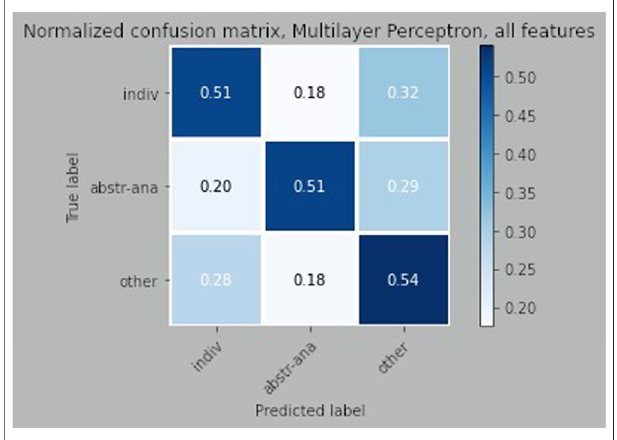
FIGURE 2 | Normalized confusion matrix for the NOMCO